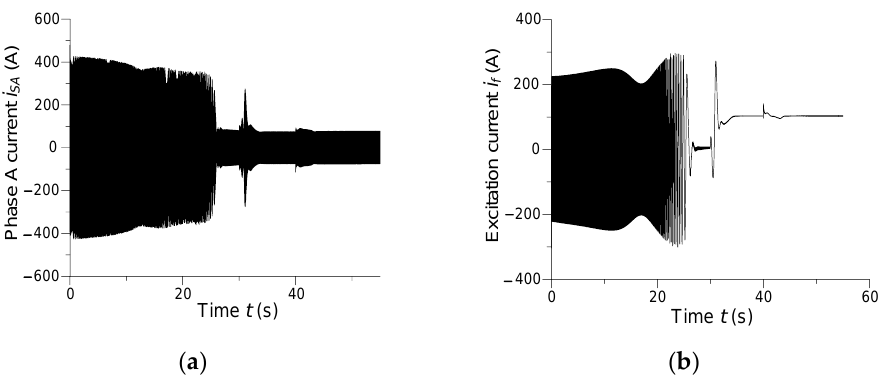
Figure 16. Instantaneous waveforms of: ( a ) A current of the synchronous motor’s armature wiring; and ( b ) excitation current of the synchronous motor.